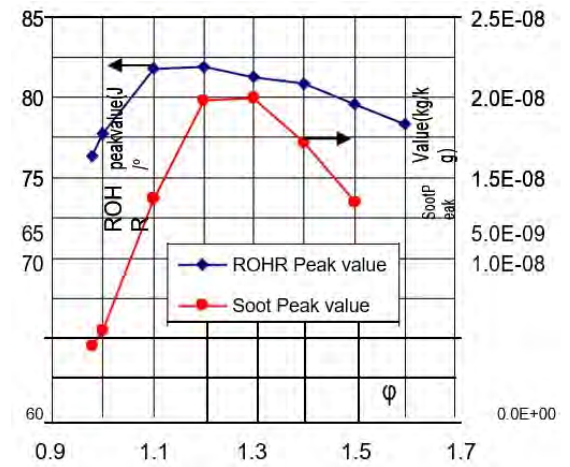
Figure 6. ROHR peakvalue and soot peak value vs equivalence ratio (D20,n=2400rpm)